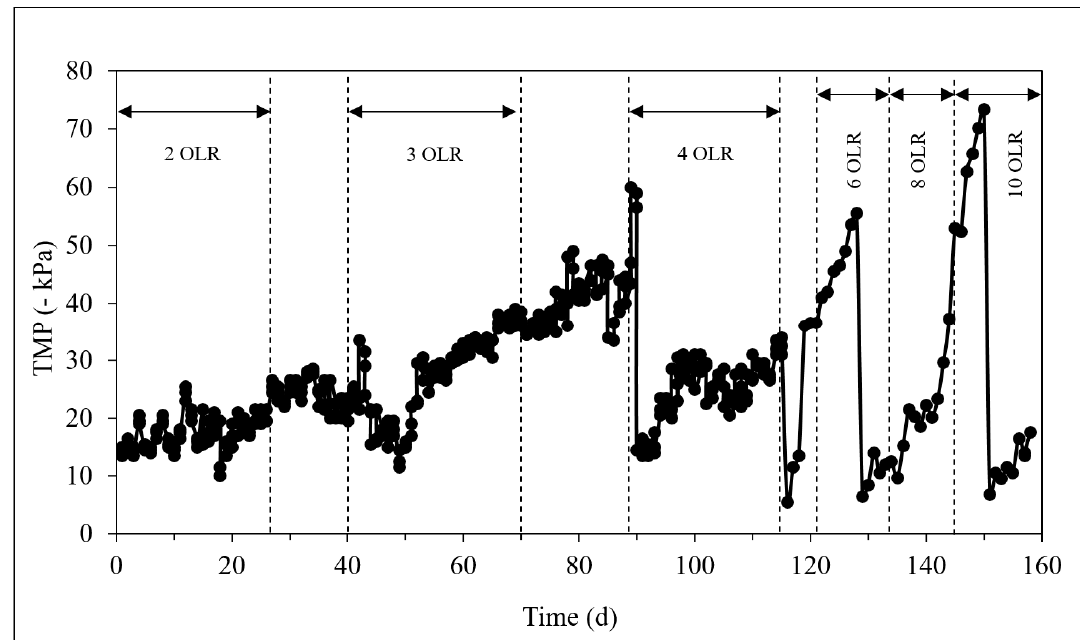
Figure 7 . Transmembrane Pressure (TMP) variation vs. time for the TAnMBR. Figure 7. Transmembrane Pressure (TMP) variation vs. time for the